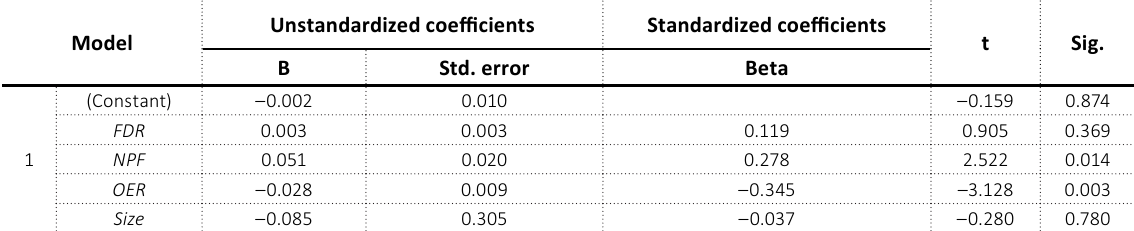
Table 12. Results of the regression analysis of Malaysian Islamic banks Unstandardized coefficients Standardized Model